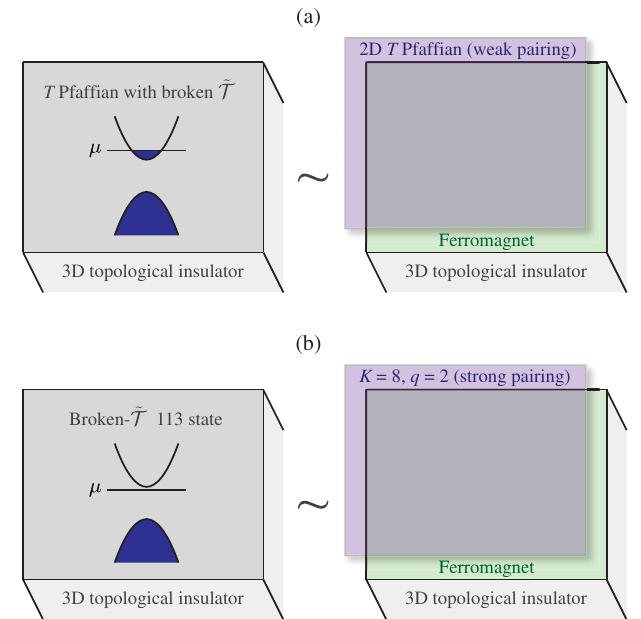
FIG. 5. Connection between CDL descendants in the absence ~ T of symmetry and strictly 2D topological orders. (a) With ~ T broken the pairing-gapped CDL reduces to a trivial ferro- magnetically gapped surface together with a 2D T-Pfaffian arising from a weakly paired composite Fermi liquid. (b) Conversely, the magnetically gapped CDL is equivalent to a ferromagnetic surface coexisting with a strongly paired composite-Fermi-liquid state with K matrix K ¼ 8 and charge vector q ¼ 2